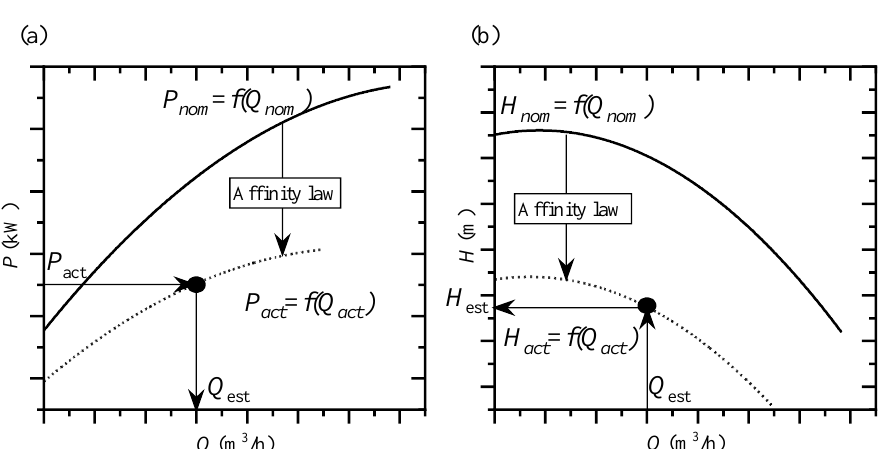
Figure 3. QP characteristic curve method: ( a ) QP curves and ( b ) QH curves.